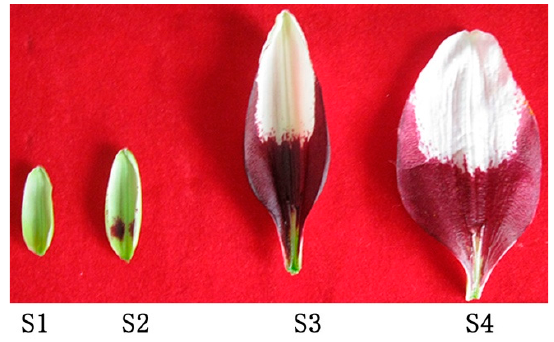
Figure 1. Tepals of the Asiatic lily cultivar ‘Tiny Padhye’ at four different developmental